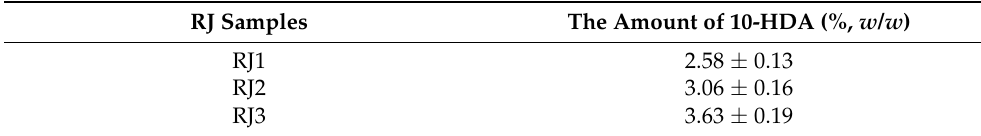
Table 1. The amount of 10-HDA in RJ samples determined by